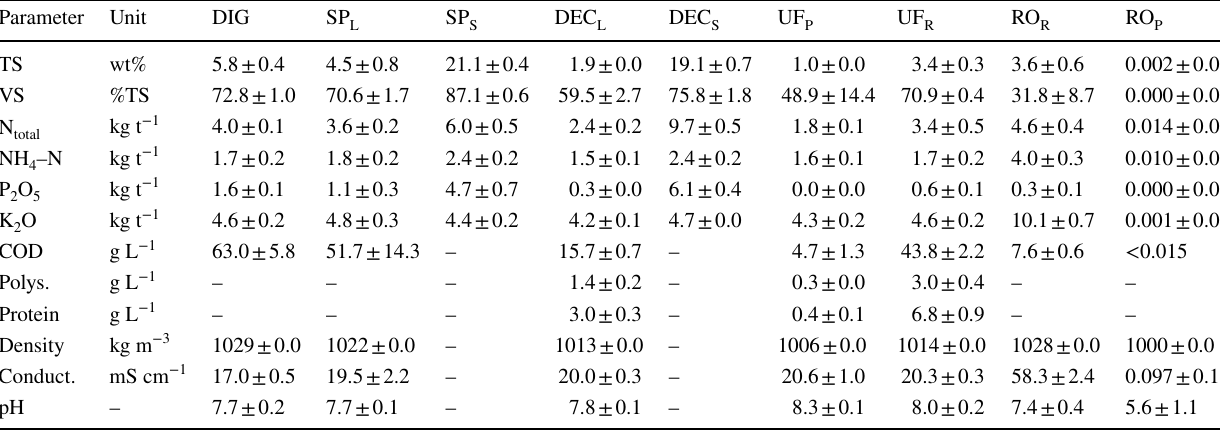
Fig. 4 f.l.t.r: Liquid phase from screw press (SP decanter (DEC L ), UF retentate (UF R ), UF permeate (UF P ), RO reten- tate (RO R ), RO permeate (RO P ) Table 1 Characterisation of process streams: digestate (DIG), liquid phase from screw press (SP tant from decanter